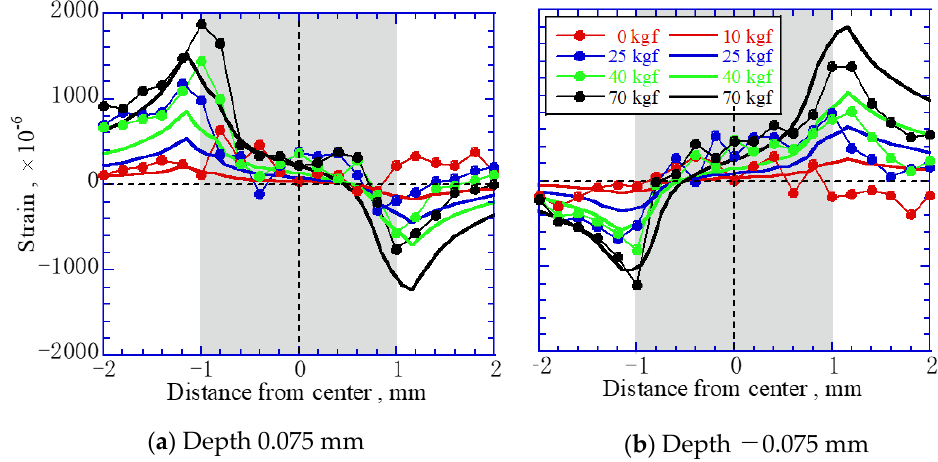
Figure 8. Strain distribution near the interface by FEM (solid line) and measurements (dotted line).